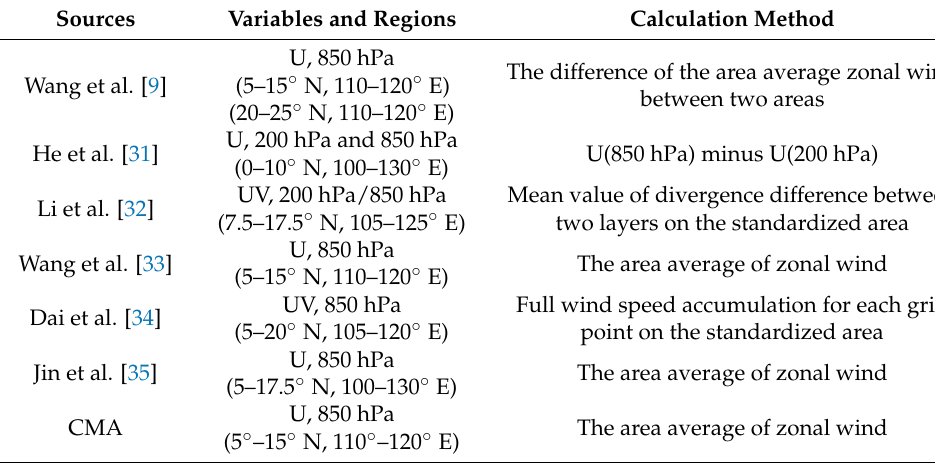
Table 1. Seven indices of the SCSSM with different